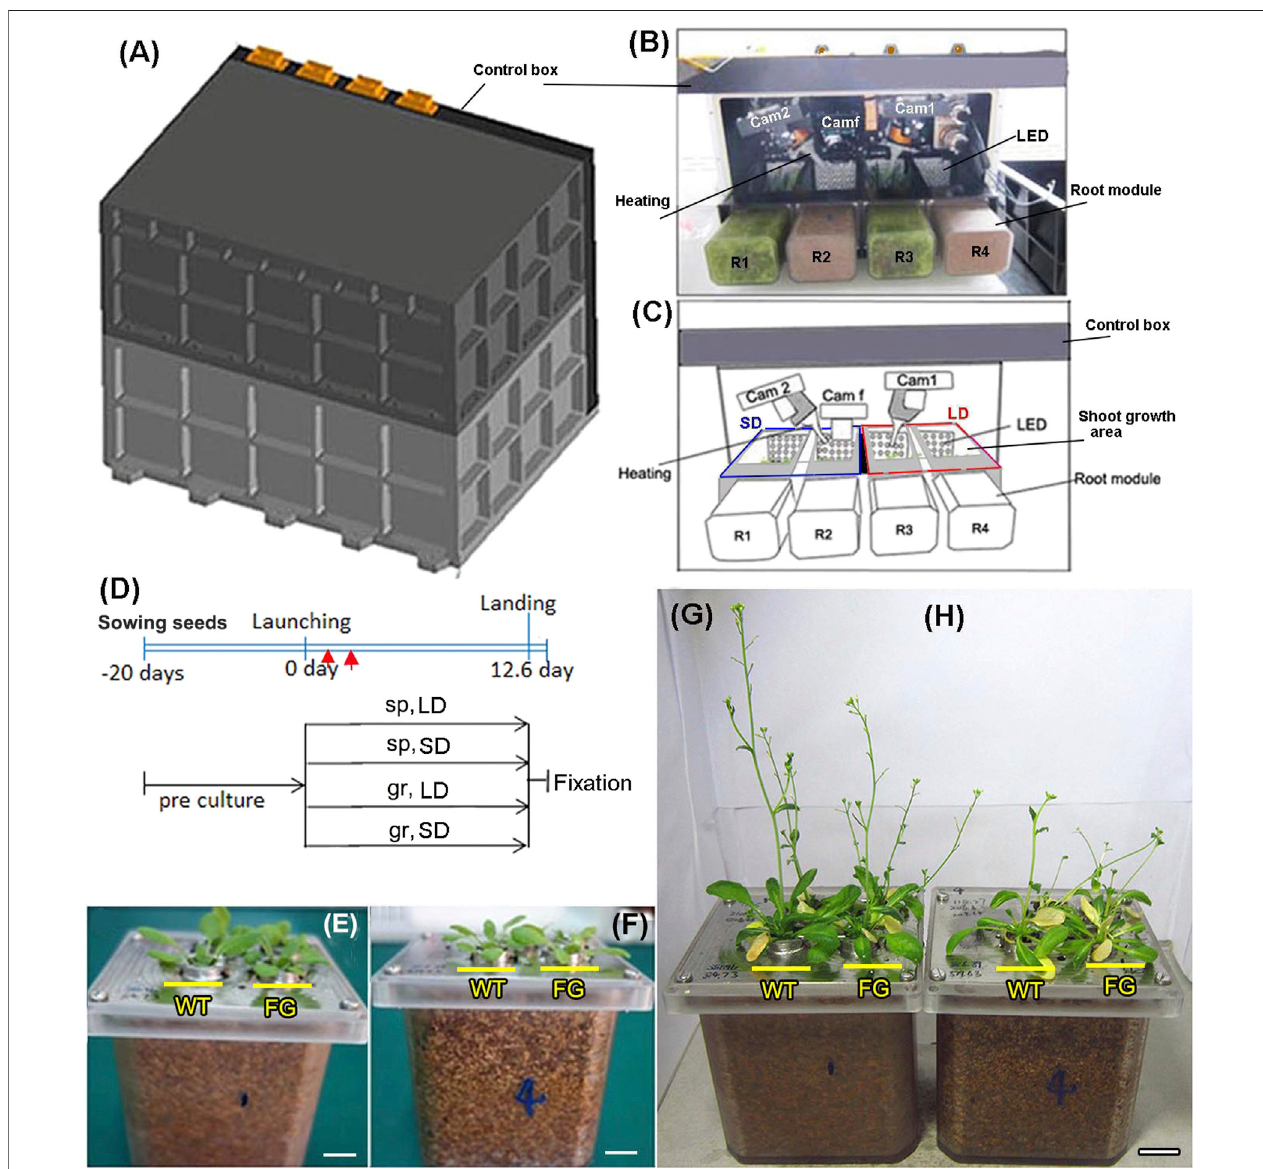
FIGURE 1 | Experimental setup on board the Chinese recoverable satellite SJ-10. (A) The external view of the plant growth unit (PGU) (H × W × D (cid:1) 370 × 270 × 270 mm) with the cover. (B) The inside view of the PGU without the cover,as described in (C) . (C) Diagram of PGU used on board the Chinese satellite SJ-10. Showing the distribution and state of components and samples in PGU during space fl ight. The components included four root modules, three cameras, two fans and heating parts, and four LED banks with controlled a long-day (LD, 16 h light/8 h dark) and a short-day (SD, 8 h light/16 h dark) photoperiods, respectively. LED plates, heating systems, video CCD cameras (Cam 1 and Cam 2), the GFP imaging camera (Cam f) and root modules (R1 and R3 with rice seedlings; R2 and R4 with Arabidopsisseedlings)areindicated. (D) Anoverviewofthetimeprocessofthespaceexperiment.wild-type(WT)andtransgenic( pHSP:FT;pHSP:GFP,FG )plantswere germinated and grown in the root module in green house on ground for 20 days after sowing (pre-culture). At this age, all plants had six to seven rosette leaves were selected to load into the PGU less than 24 h prior to took off. Heating treatment (red arrows point) to activate expression of FT and GFP was performed at day 2 on orbiter.TheplantsinthePGUweregrownundertheLDandtheSDconditionsinspace(sp)andonground(gr),respectively. (E,F) 20-dayoldWTandFGplantsgrownin the root modules before being loaded into chambers of the PGU under the LD (E) and the SD (F) conditions, respectively. (G,H) The situation of samples of (E) and (F) recovered from space fl ight under the LD (G) and the SD (H) conditions in the PGU. Bars (cid:1) 1 cm.